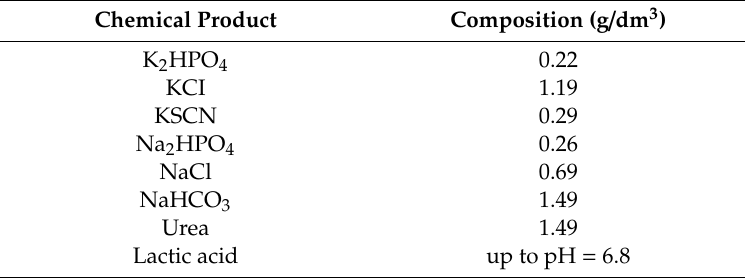
Table 1. Compounds of the artificial